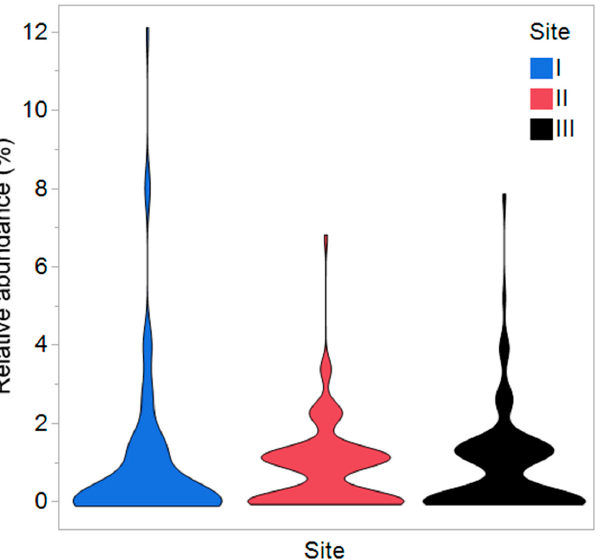
Figure 3. Violin plot of relative abundance (%) of 121 morphotaxa in bark and xylem samples collected from elms growing at the three sites where vaccinations were ongoing at the time of sampling (Site I), where vaccinations had ceased (Site II) and where trees had not been vaccinated (Site III). Median test: ChiSquare 13.58, df = 2, p = 0.0011. Six morphotaxa were recovered from all three sites (Figure 4). Samples from site II yielded the highest number of unique morphotaxa (only found at one site), whereas the lowest number of unique morphotaxa was recovered from site I samples (Figure 4). Site II shared more morphotaxa with site III than with site I (Figure 4).